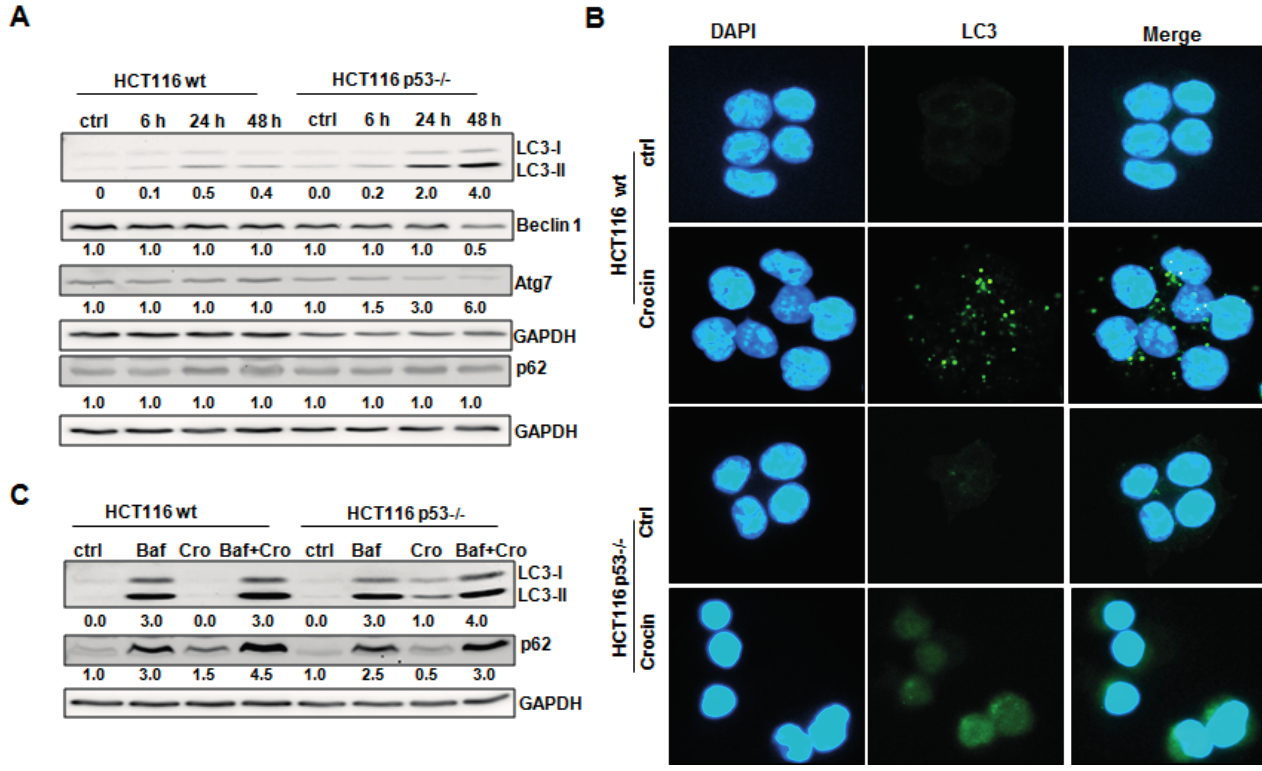
Figure 4. Crocin-induced autophagy in HCT116 cells. ( A ) Lysates prepared from two cell types, HCT116 wild-type (wt) and HCT116 p53 − / − , untreated (Ctrl) or treated with 10 mM crocin for 6, 24, and 48 h, were analyzed by anti-LC3, anti-Beclin 1, anti-Atg7, anti-p62, and anti-GAPDH Western blotting. GAPDH served as the internal control for equal loading; ( B ) Fluorescence staining of LC3 and DAPI in two cell types, HCT116 wild-type (wt) and HCT116 p53 − / − , control and treated with 10 mM crocin for 24 h; and ( C ) Lysates prepared from two cell types, HCT116 wild-type (wt) and HCT116 p53 − / − , untreated (Ctrl) or treated with Bafilomycin A1 (Baf, 10 nM) for 1 h and/or further treated with 10 mM crocin (Cro) for 48 h were analyzed by anti-LC3, anti-p62, and anti-GAPDH Western blotting. GAPDH served as the internal control for equal loading. The ratios represent protein alterations compared to the